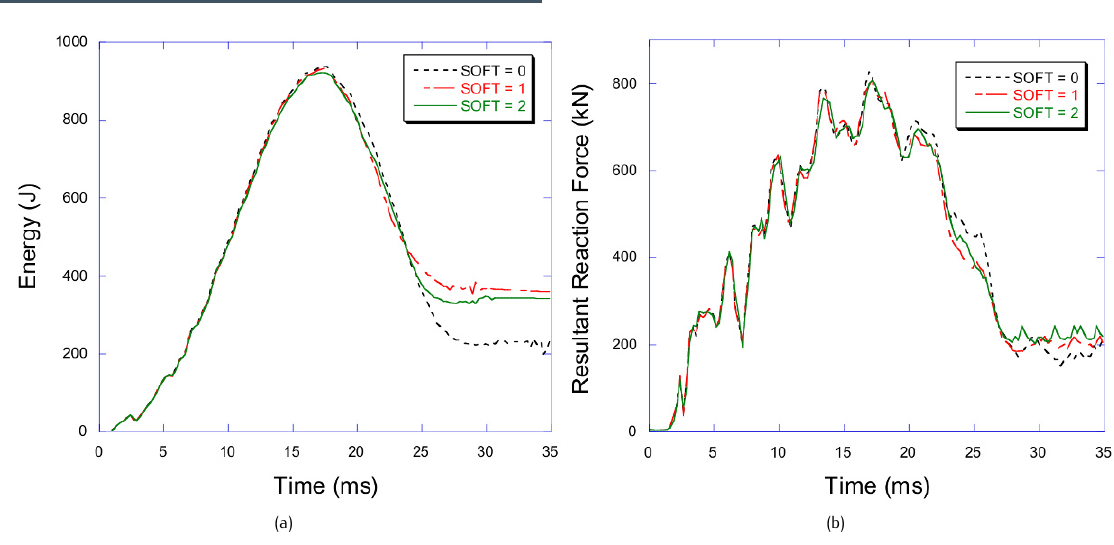
Figure 10. Comparison of (a) absorbed energy and (b) reaction force from FEA of the impacted substructure with 1 shell (24 integration points) with different SOFT